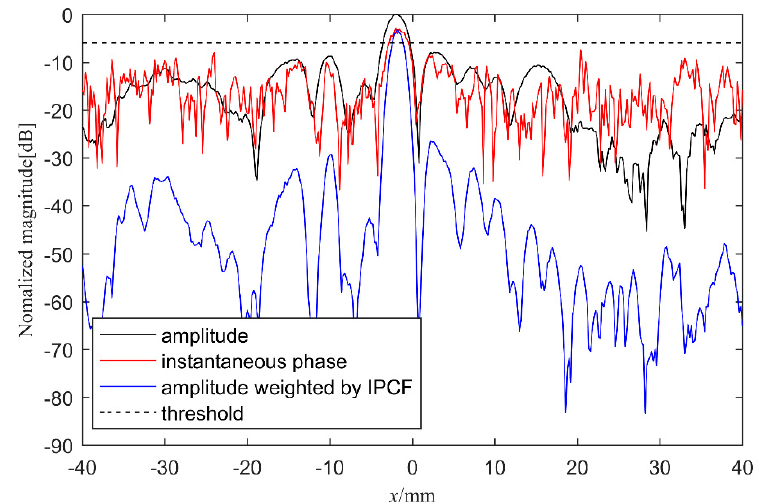
Figure 7. Axial view for z = 15 mm in plate B, with amplitude shown with the black line, instantaneous phase shown with the red line, IPCF( σ = 1) shown with the blue line, and instantaneous phase threshold shown with the dashed line.